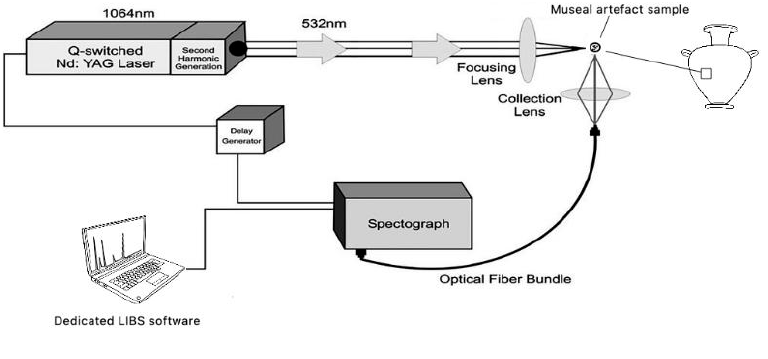
Figure 2. Typical Laser-induced breakdown spectroscopy (LIBS)